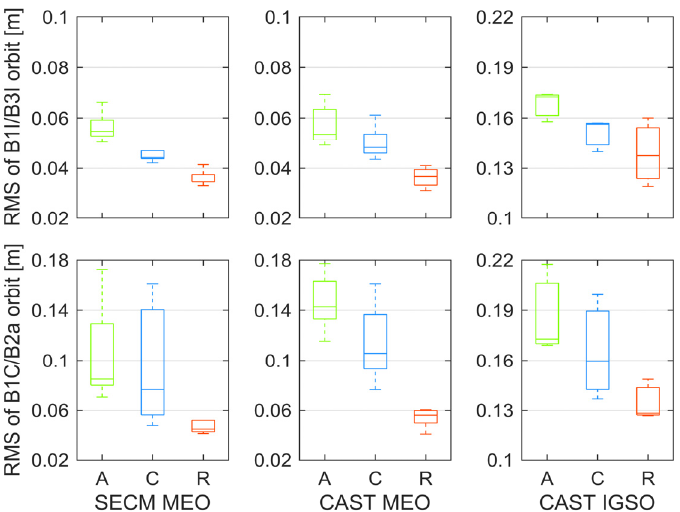
Figure 7. RMS of BDS-3 ISR orbits based on B1I/B3I and B1C/B2a compared with different MGEX ACs in the along-track (A), cross-track (C), and radial (R) directions, respectively.